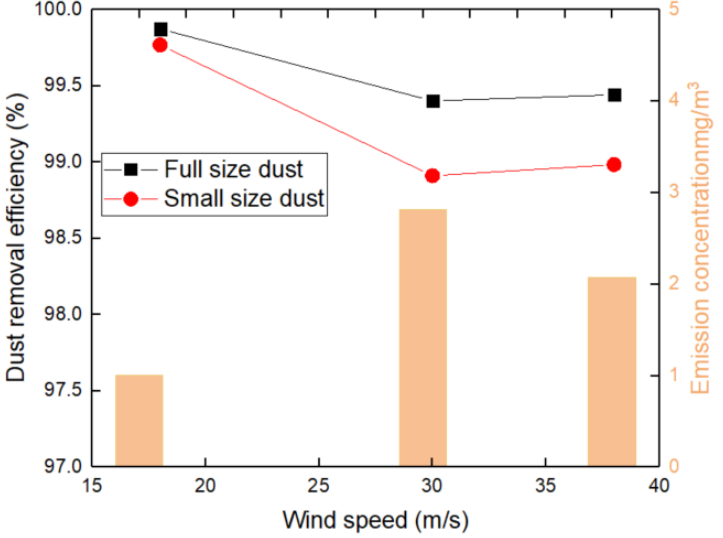
Figure 9. Dust discharge concentrations after the purification process and dust removal efficiencies of full-size and small-size dust